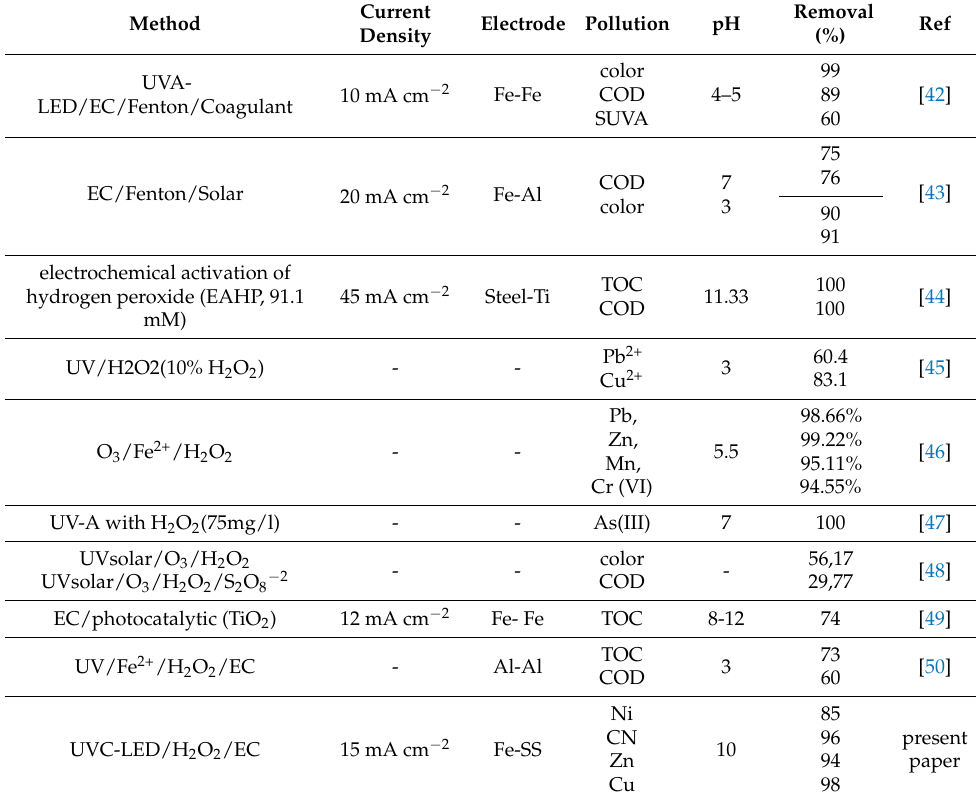
Table 5. Studies on the removal of heavy metals with hydrogen